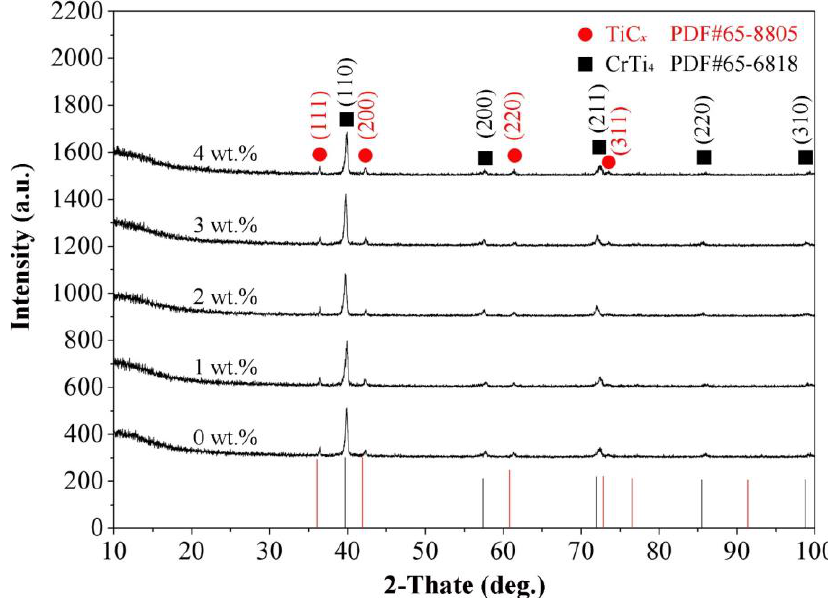
Figure 4. The XRD pattern of the Ti6Al4V/NiCr-Cr 3 C 2 /CeO 2 laser cladding coatings.